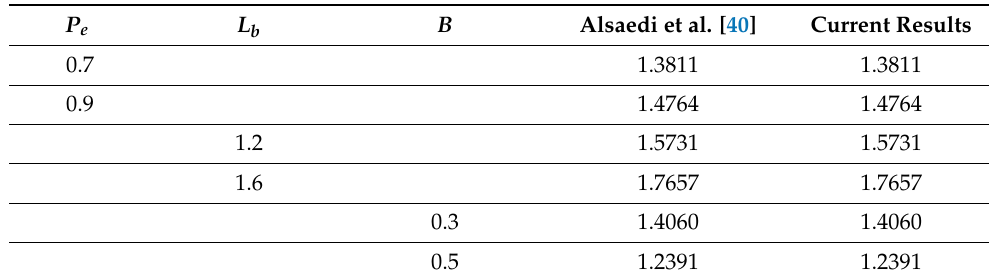
Table 4. The current approximated values of − Φ (cid:48) ( 0 ) compared across the former work by granting β D = F r = 0.